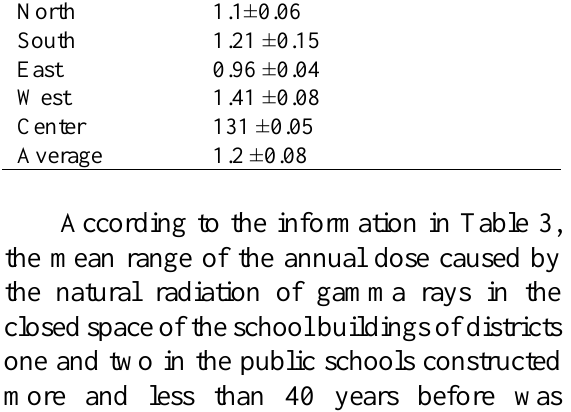
Table 2. Total mean dose rate in closed space of public schools of districts one and two of Hamadan as separated by geographical direction in 2016-2017 Geographical Annual absorbed dose rate directions